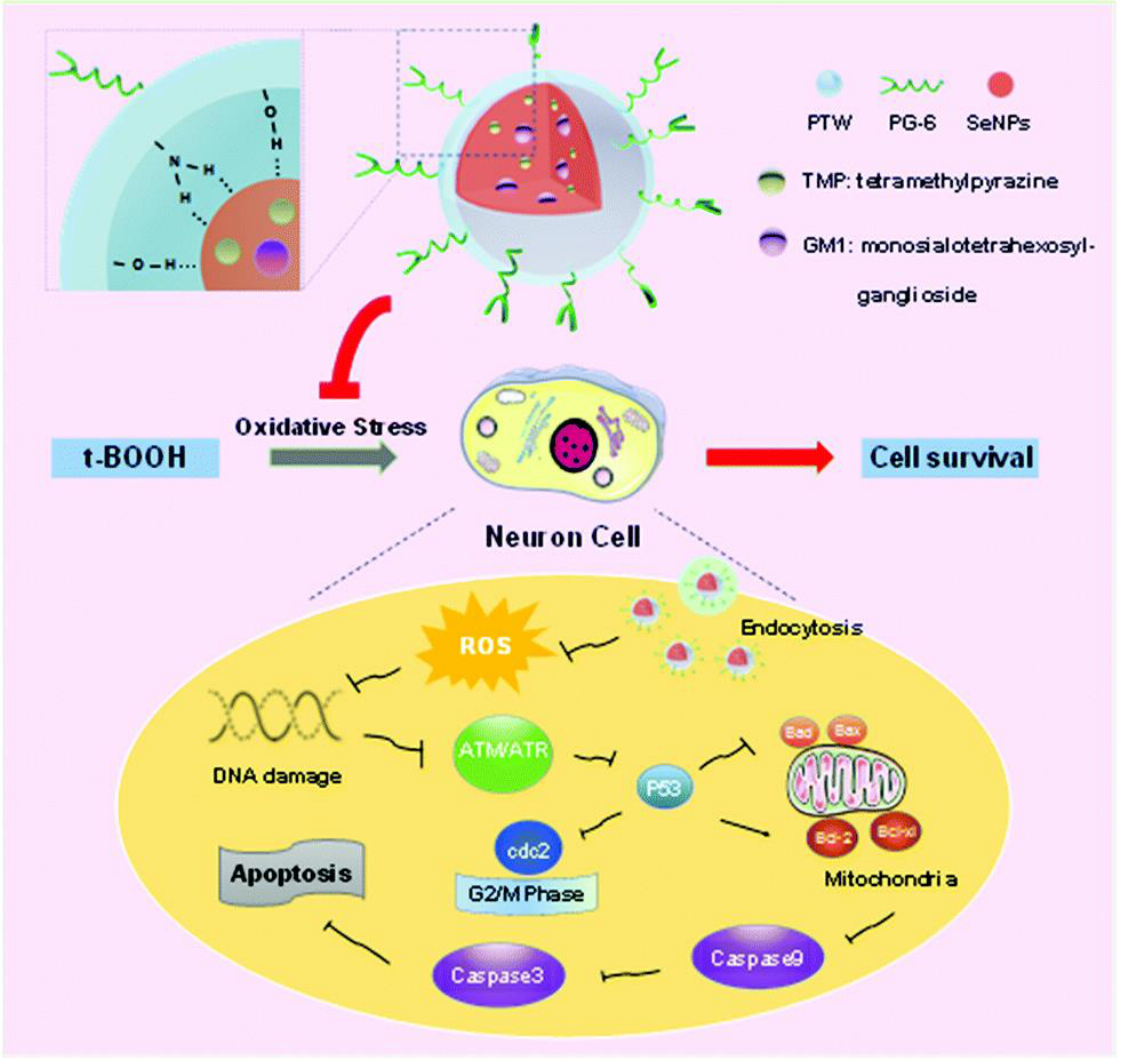
Figure 4. Structure of SeNPs@GM1/TMP and their protective activity against t-BOOH induced neuron cell death. Reproduced with permission from Ref. [264]. 2019, the Royal Society of Chemistry.